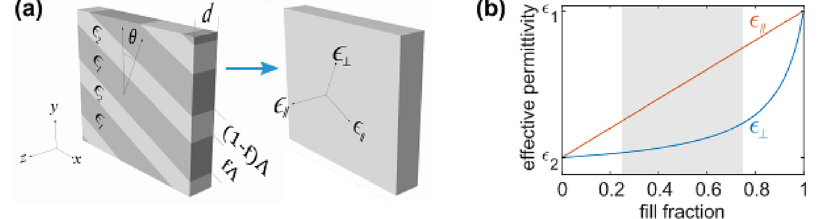
Figure 12: All-dielectric stacks of high contrast gratings (reprinted with permission from Ref. [67]). (a) Each grating is homogenized into an anisotropic layer using effective medium theory. By controlling the fi ll fraction within each layer, the anisotropiceffectivepermittivitycanbecontrolled.Stacksoftheeffectiveanisotropiclayersprovidebianisotropicresponsesanalogoustothe three electric sheet implementations of bianisotropic